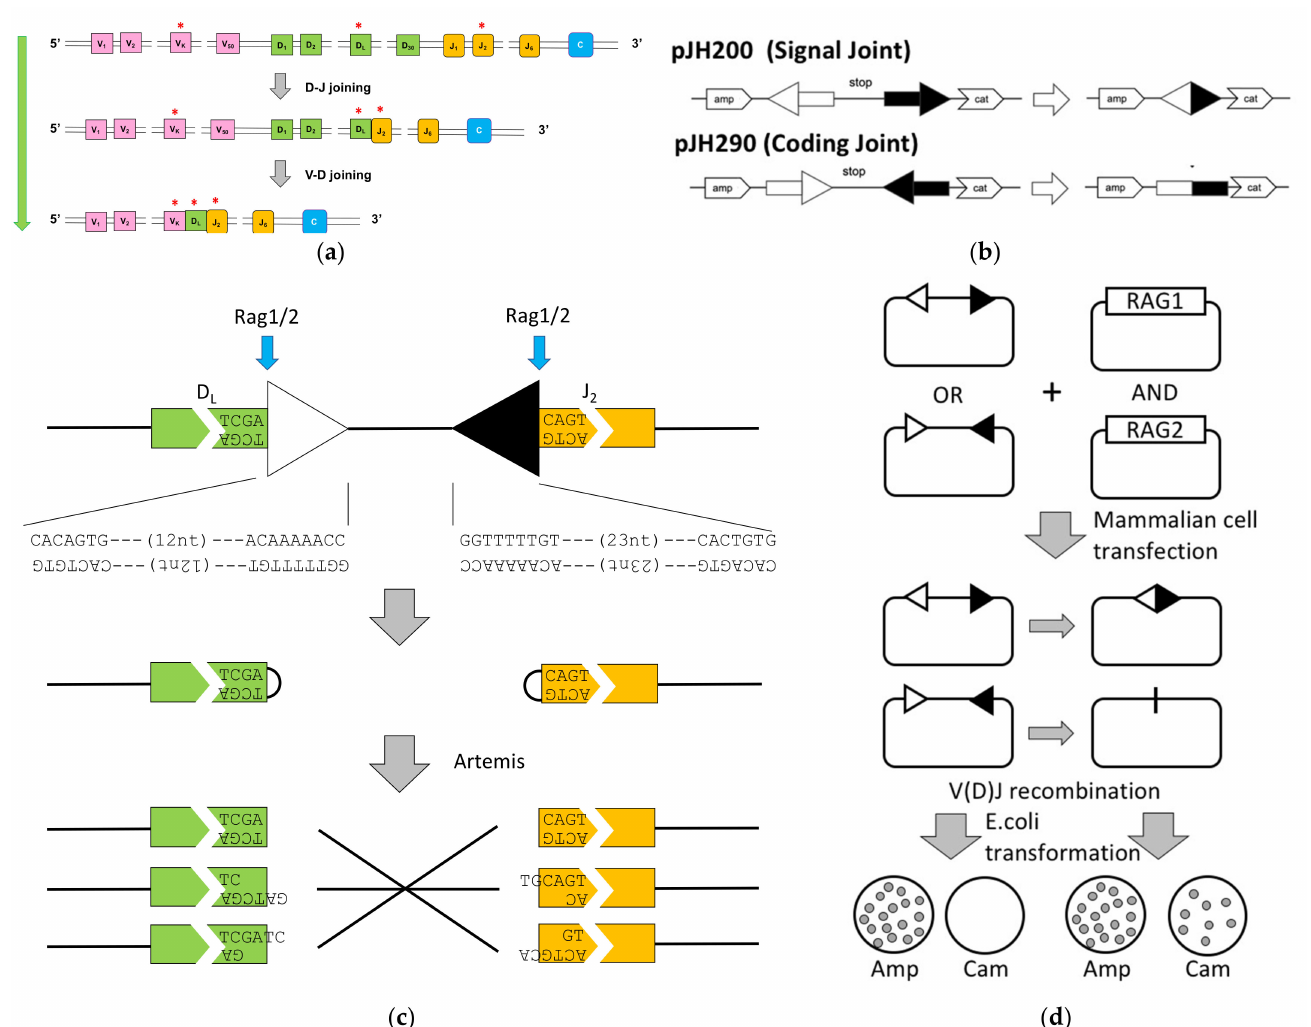
Figure A1. Schematic diagram of V(D)J recombination and its measurements. ( a ) V(D)J recombination in the human immunoglobulin heavy chain locus. Red asterisks indicate the selected segments, which are joined together. ( b ) The recombination signal sequence (RSS) and its cleavage by Rag1 and Rag2, generating a blunt signal end and hairpin coding end. Opening the hairpin by Artemis can generate blunt, 5 (cid:48) -overhanging and 3 (cid:48) -overhanging ends, which can be joined in any combination. ( c ) Substrate plasmids for the measurements of the signal joint formation (pJH200) and coding joint formation (pJH290). ( d ) Outline of the V(D)J recombination